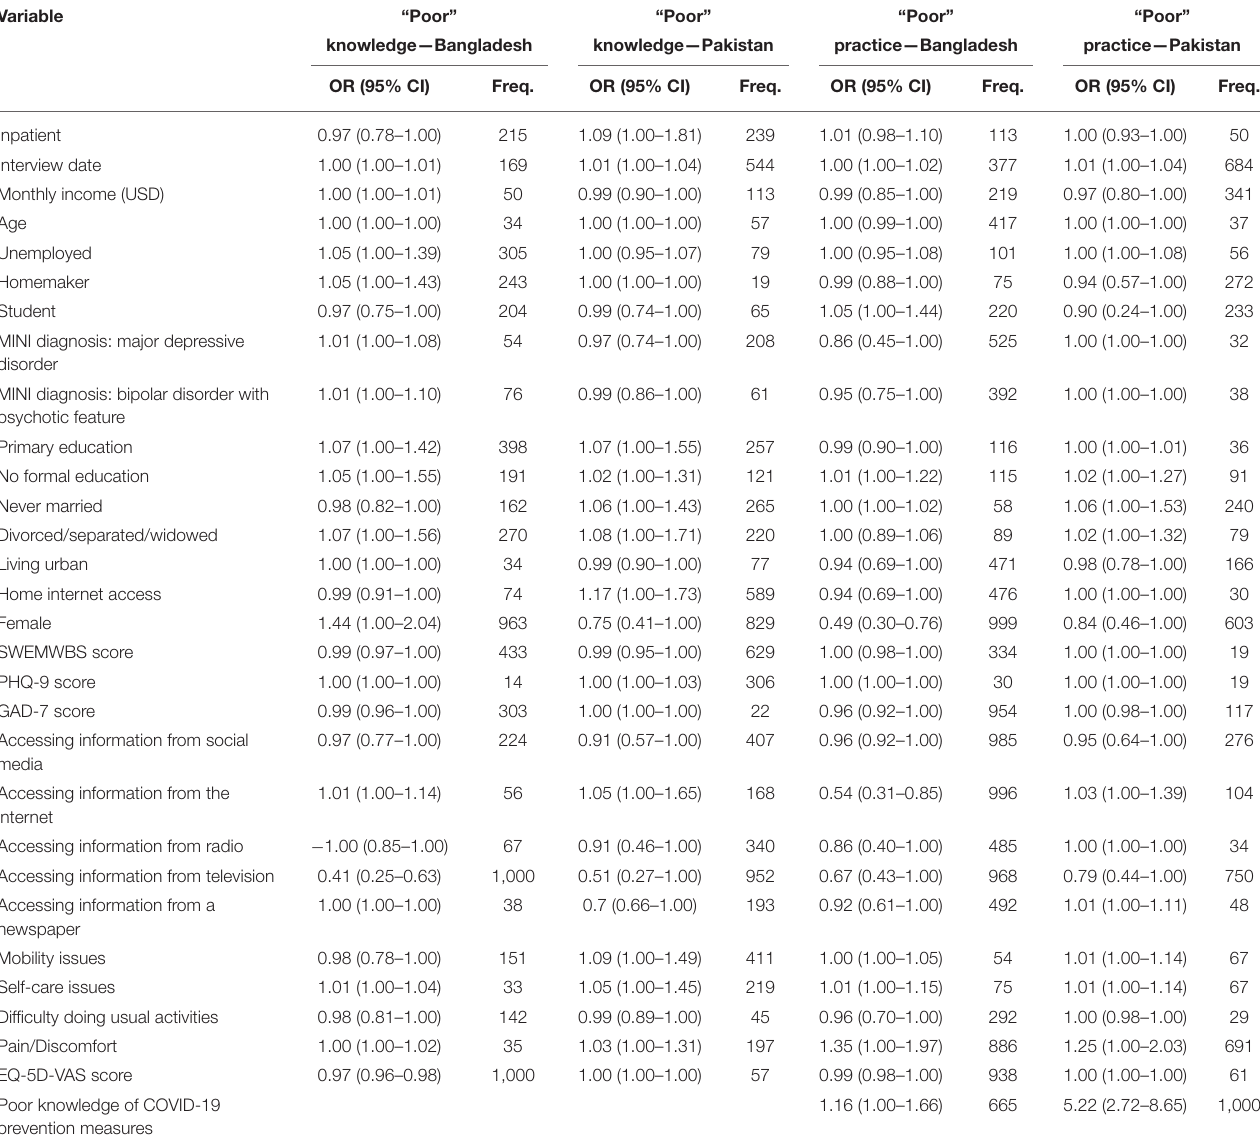
TABLE 7 | Results of the regularized logistic regression models ( N = 845 Bangladesh; N = 451 Pakistan) predicting comparatively poor knowledge and limited prevention practice. Variable “Poor”